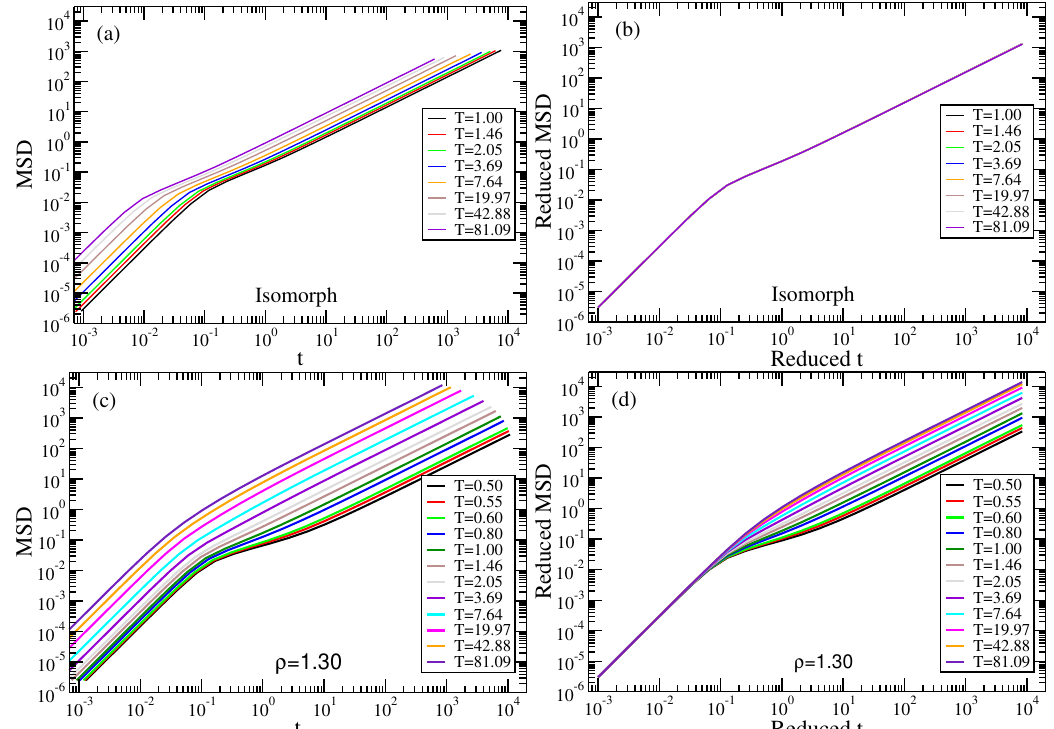
Figure 11. A particle (Y atom) MSD of the NiY 2 binary LJ mixture along the isomorph in LJ and reduced units ( a , b ), and similarly along the ρ = 1.30 isochore ( c , d ). Only along the isomorph is the MSD invariant in reduced